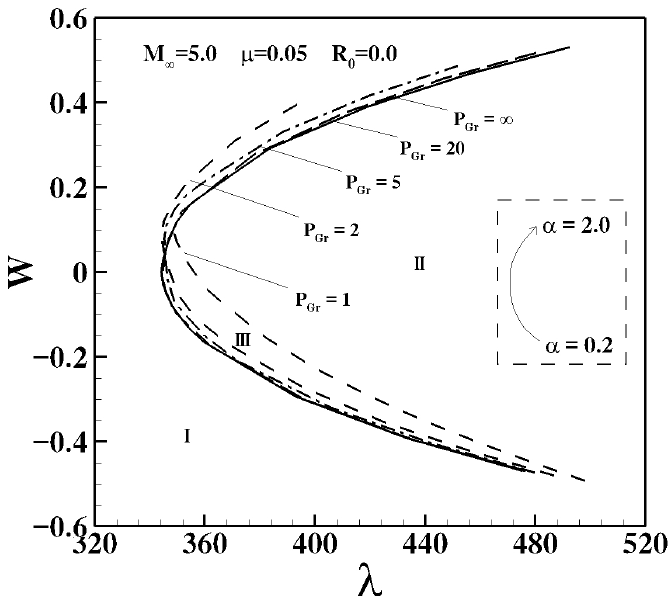
Figure 13. The buckling deformation versus the critical dynamic pressure. The coolant injection direction is another important factor in the analysis of panel stability. Figure 14 plots the curves of the peak of deformation versus the freestream dynamic pressure under the condition of the forward injection and reverse injection of coolant. The injection direction mainly affects three aspects of the panel response. First, in the buckling state, the buckling deformation under forward injection is smaller than that under the reverse injection when the dynamic pressure is small, while the magnitude relationship changes when the dynamic pressure is large. There is obviously a transition point. With the increase in α , the values of λ corresponding to the transition points are 140, 94, 49.5, and 111.1, respectively. Second, the position at which the bifurcation occurs is also different. The bifurcation occurs first when the coolant is injected reversely when α is equal to 0.6 and 1.0, while opposite results are obtained when α is equal to 1.4 and 1.8. Third, the peak of LCO when the coolant is injected forward is larger than that when the coolant is injected reversely, and the difference between the peaks increases with the increase in α